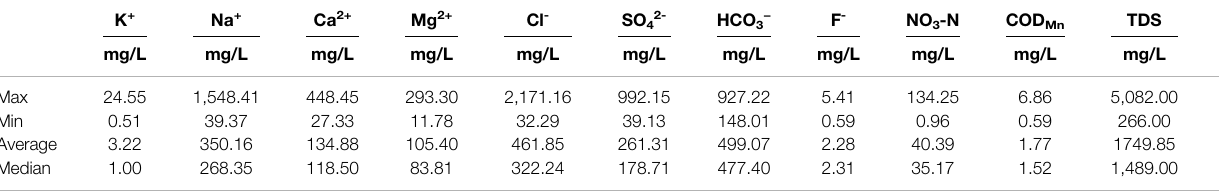
TABLE 3 | Minimum, median, maximum and average values of chemical variables in 47 groundwater